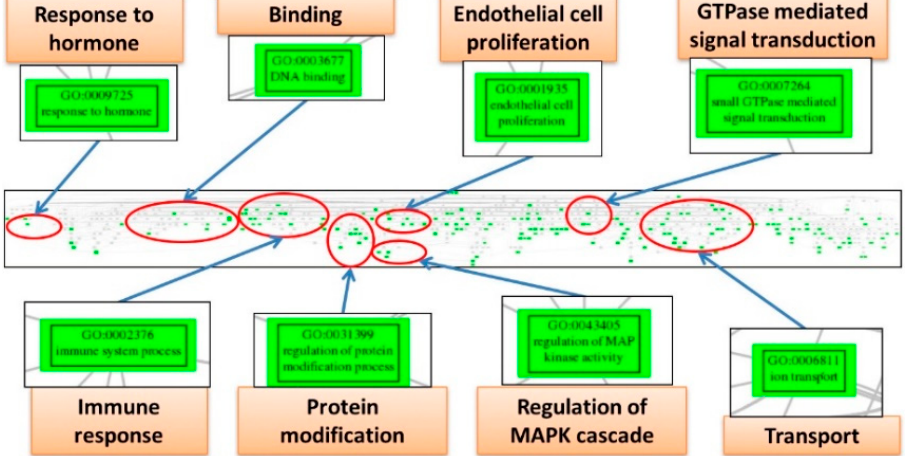
Figure 4. The Gene Ontology tree of deregulated functions from exploratory factor analysis for endometriosis. The figure displays the screenshot of the full Gene Ontology (GO) tree for endometriosis (ES) (middle panel). After mapping to the GO tree, the similar or related GO terms are clustered together. Each cluster is circled (red), and the important deregulated GO terms (green boxes) in the cluster are magnified to view the details. Each cluster is labeled by the common parental GO term (orange rectangle).